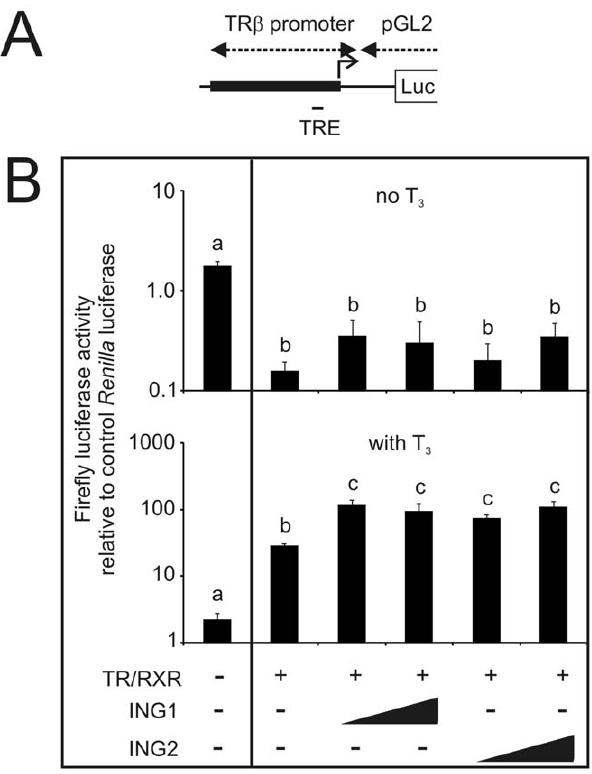
Figure 4. ING proteins enhance the ability of TRaˆ to activate transcription in the presence of T 3 in a Xenopus oocyte transcription system. Microinjection experiments were performed using stage VI Xenopus oocytes. The oocyte cytoplasm was injected with the indicated mRNAs (1.15 ng/oocyte for TR and RXR, 1.15 or 2.3 ng/oocyte for ING1 and ING2). Following mRNA injection, all oocytes were injected in the germinal vesicle with the luciferase reporter plasmid TRE-Luc (0.33 ng/oocyte) which has the T 3 -dependent TRaˆpromoter containing a TRE driving the expression of firefly luciferase (‘‘pGL2’’ shown in ‘‘A’’), and the control vector phRG-TK driving the control Renilla luciferase (0.03 ng/oocyte: Promega). B) The injected oocytes were incubated at 18 u C overnight in the presence or absence of 50 nM T 3 . The oocytes were assayed with a Dual-Luciferase H Reporter Assay System (Promega). Plotted are the averages and the standard errors of the mean firefly luciferase activity relative to the Renilla luciferase activity. These results are from two experiments each done in triplicate. The error bars represent the standard error of the mean, and statistical significance of data relative to each other (p , 0.05, Mann Whitney U) is indicated by different letters. Bars with the same letters are not statistically different from each other. Note that the scales of the two graphs are different.